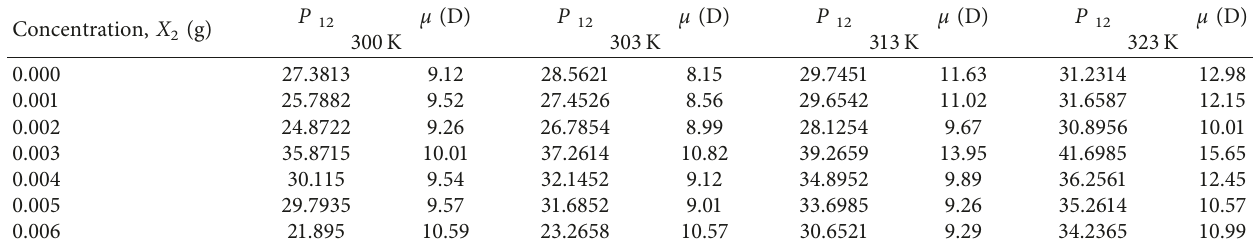
12 ) and dipole moment ( μ ) values of BaO: Therm500 nanofluids with different